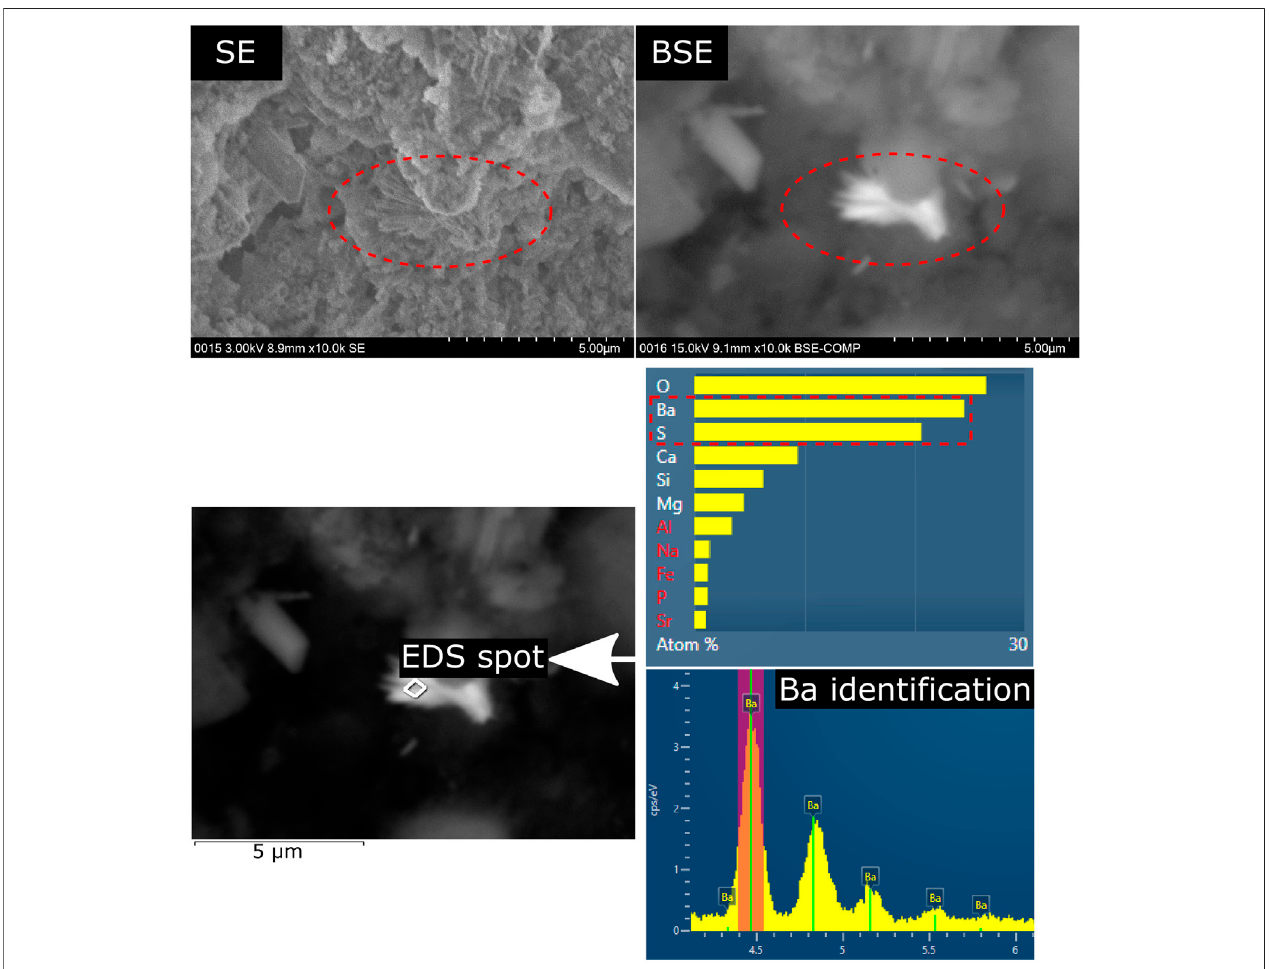
FIGURE 7 | BaSO 4 crystals at the outermost surface of a hardened binder paste with high GGBS content (65_SO4) following exposure to (30 gl − 1 SO 2 − 4 ). Such minor phases are not detected by conventional X-ray diffraction of bulk samples due to their low amount. They are formed at the interface between GGBS-rich binders and sodium sulfate solution and are evenly distributed on the samples surface. Low voltage SE image of the surface and high voltage BSE image of the atomic weight contrast. EDS measurements showed about equal amounts of barium and sulfur, barium was identi fi ed based on multiple energy bands to distinguish between barium and